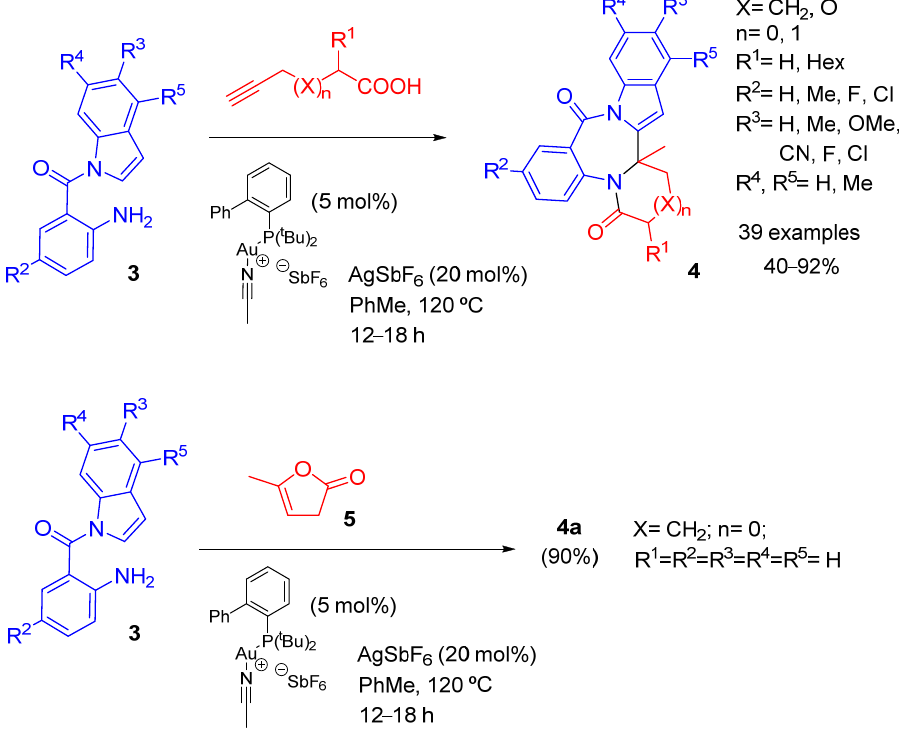
Figure 2. Diastereoselectivity observed in the cascade reactions with phenylenediamines or o -ami- nobenzylamines reported by Patil and col.